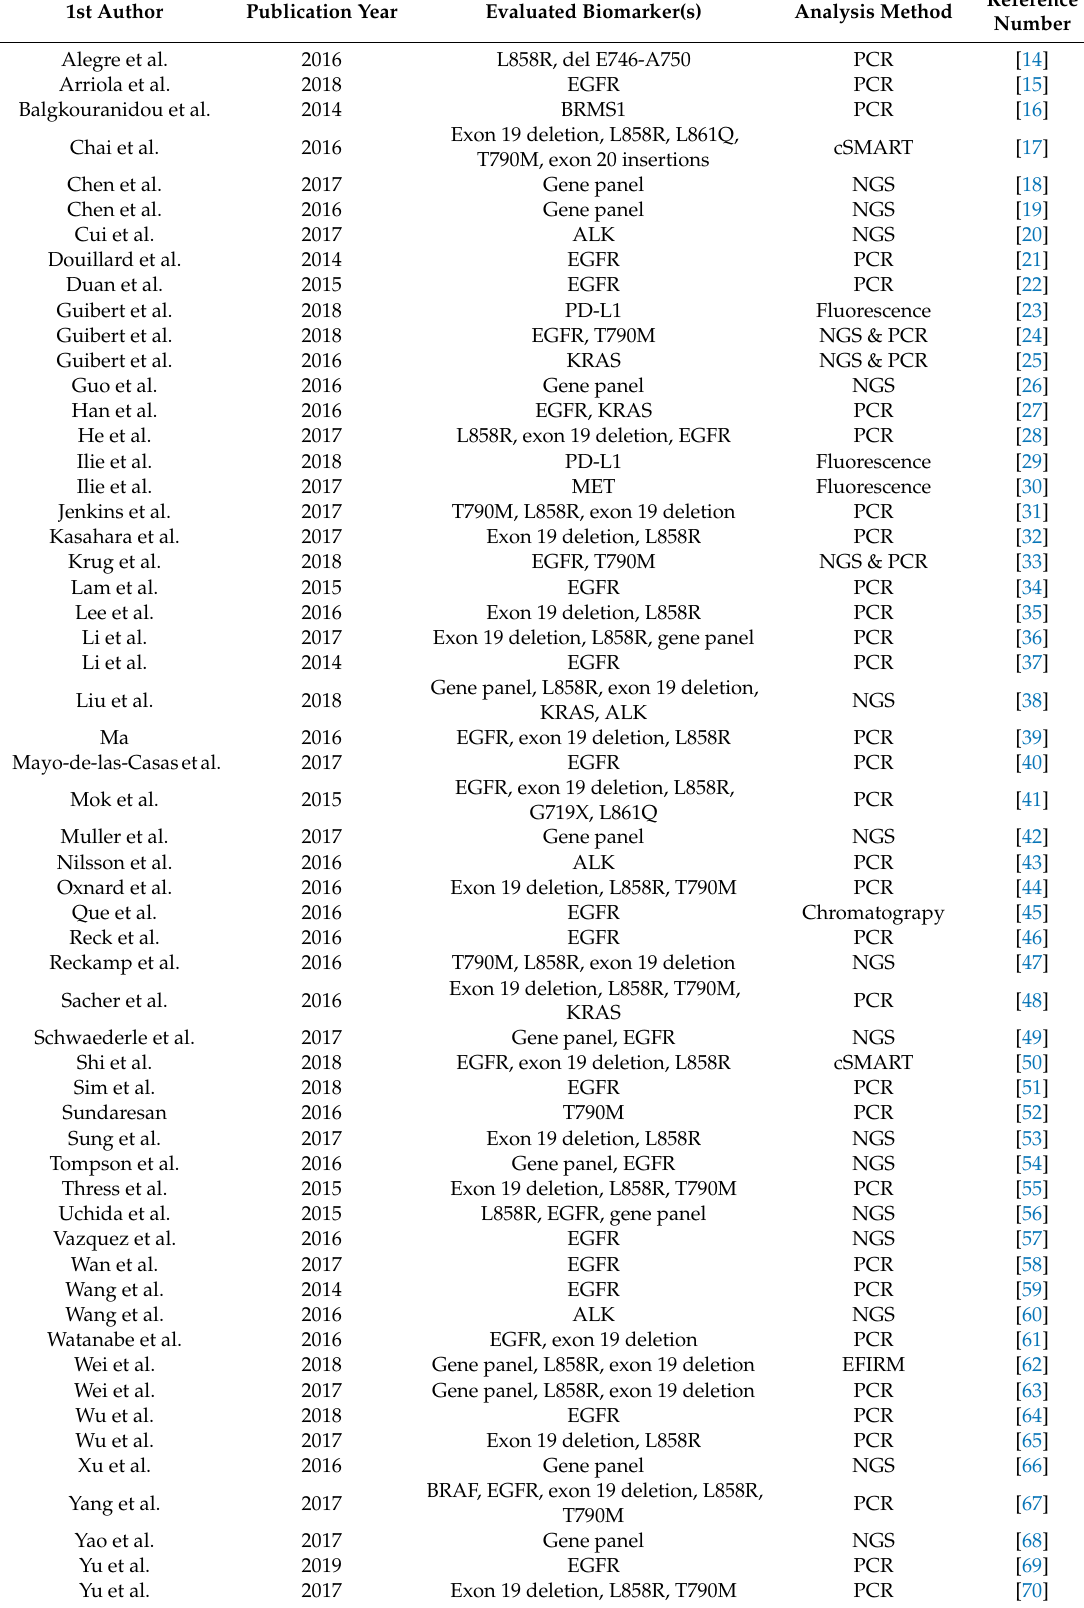
Table 1. Description of included studies describing the validity of a liquid biopsy-based